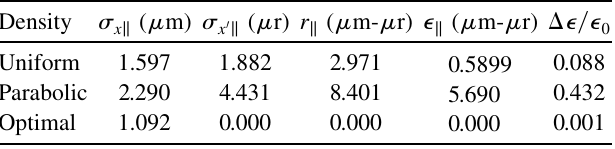
TABLE V. Relative CSR-induced emittance growth at the end of the final drift of the Berlin-Zeuthen benchmark chicane, assuming a matched initial end-to-end bunch length of 0.738 mm (after truncating slices near the head and tail as seen in Fig.